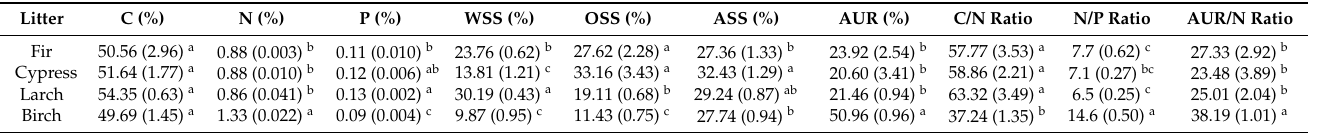
Table 1. Initial chemical compounds in the four foliar litters.